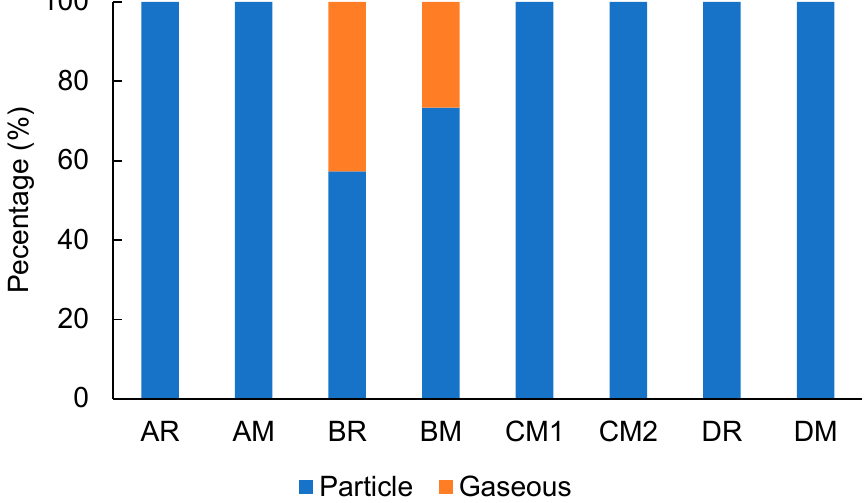
Figure 5. Percentages of particles of ammonia emitted from each heated tobacco product (average of three repeated measurements).